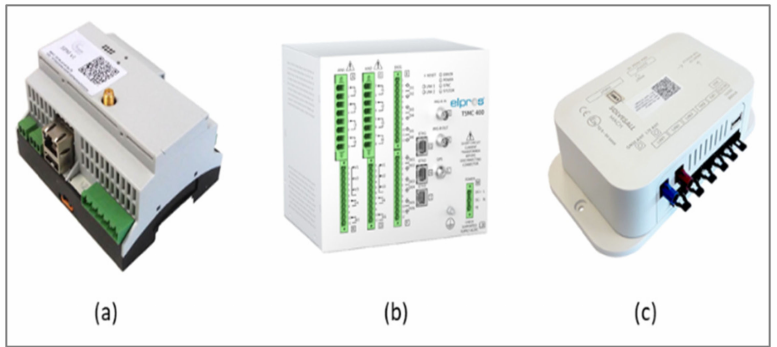
Figure 8. Observability-related sensors developed in the project: ( a ) PQM, ( b ) PMU, and ( c )